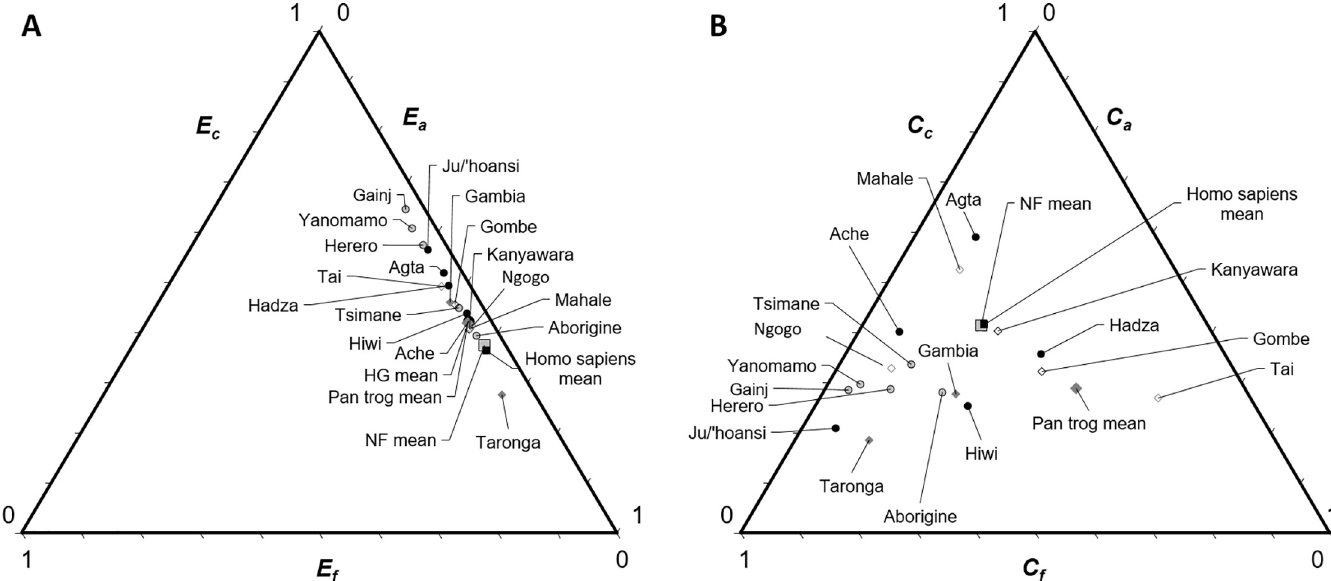
Fig 3. Ternary diagrams of elasticities and contributions. (A) Populations are arranged using the summed fitness elasticities for vital rates underlying child survival ( E , left axis), adult survival ( E , right axis) and fertility ( E , bottom axis). (B) Populations are arranged using the summed fitness effects (contribution magnitudes) made c a f by differences in child survival ( C c , left axis), adult survival ( C a , right axis) and fertility ( C f , bottom axis).